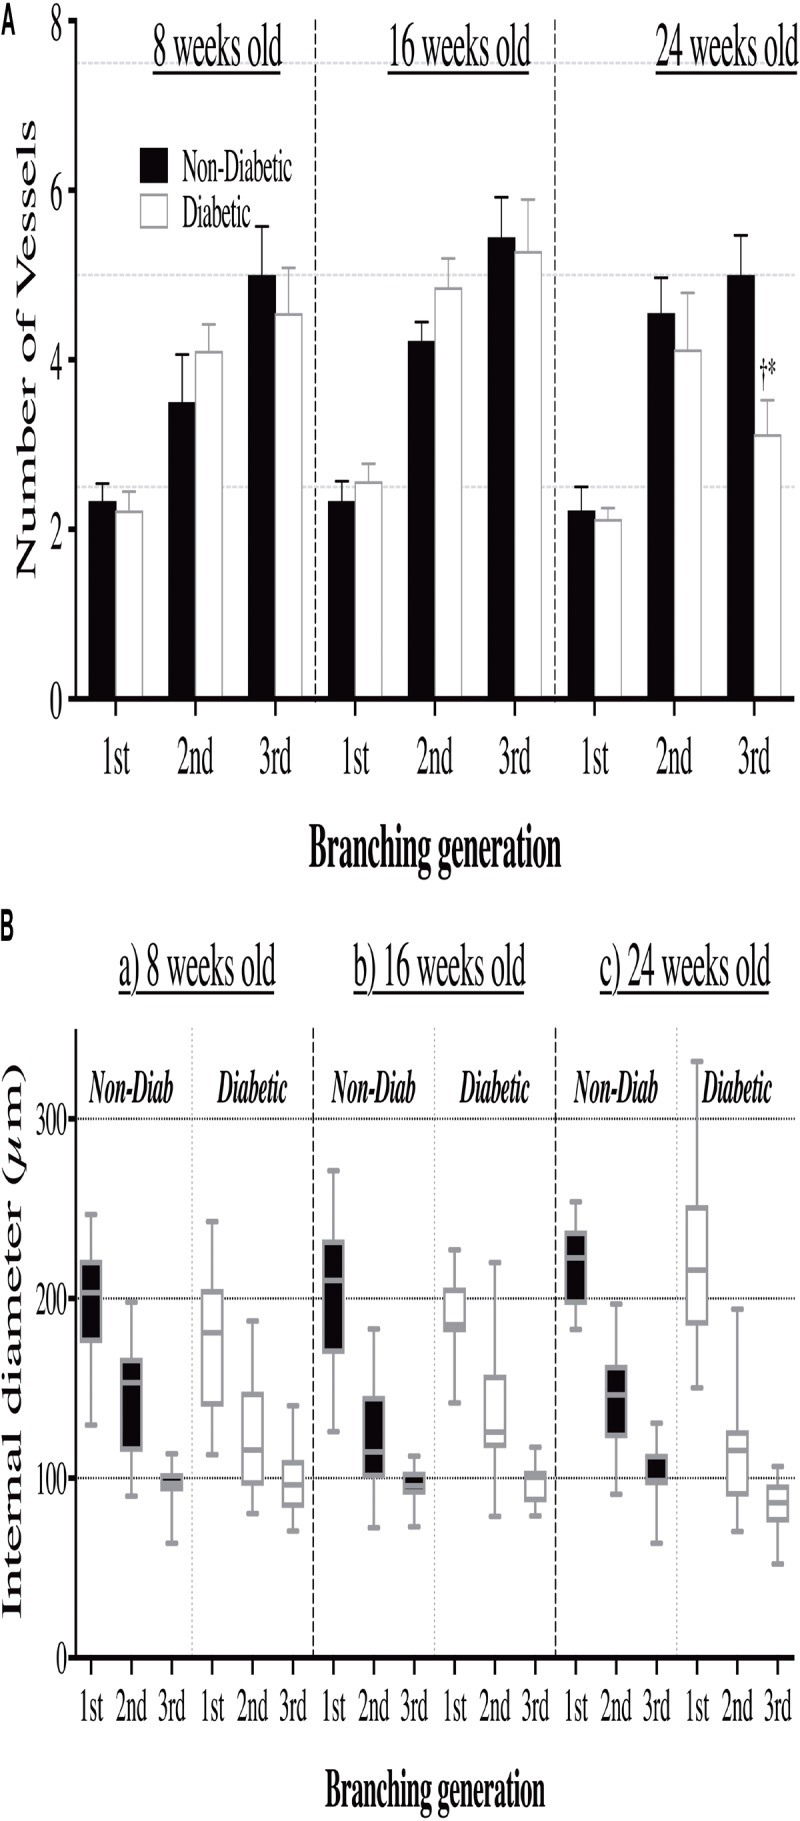
(A) The number of opaque vessels (mean ± SEM) and (B) the range of vessel sizes (box and whisker graph), at each of the first three branching generations of the coronary circulation in anesthetized db/db diabetic and non-diabetic mice at 8 weeks old (n = 8 and n = 7, respectively), 16 weeks old (n = 10 and n = 9, respectively), and 24 weeks old (n = 8 and n = 7, respectively). Quantitative data presented in A show a decrease in the number of 3rd order branches in the 24-week-old diabetic mice compared to the (i) 8 week old diabetic mice (∗P < 0.05) and (ii) age-matched non-diabetic animals (†P < 0.05).